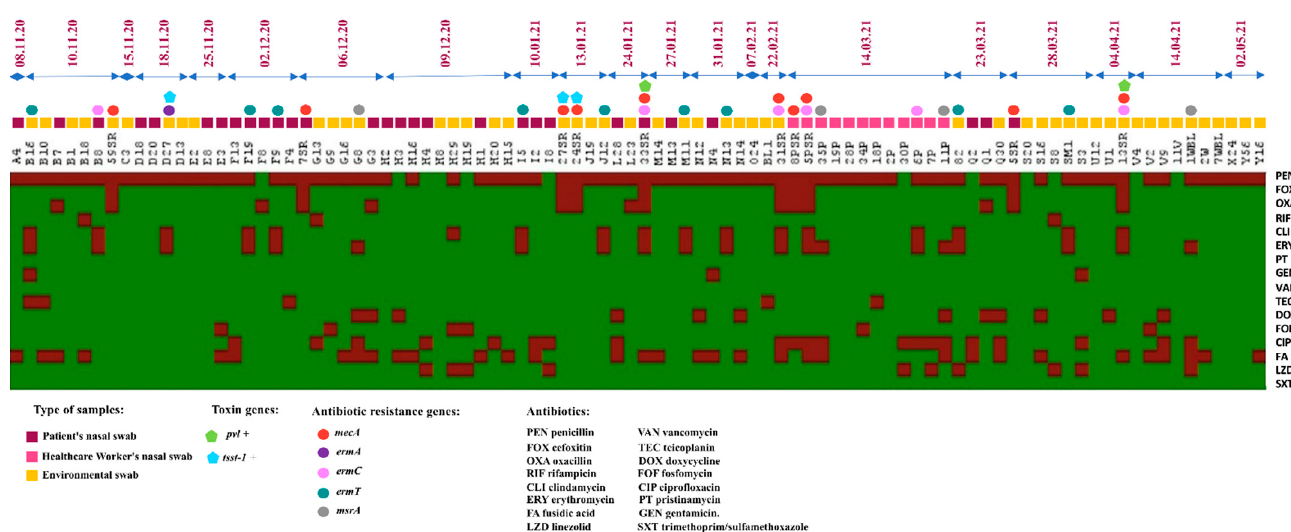
Figure 1. Illustration of the resistance phenotype, and distribution of resistance genes and toxins tested according to the origin of the isolates and grouped by the chronology of their isolation.